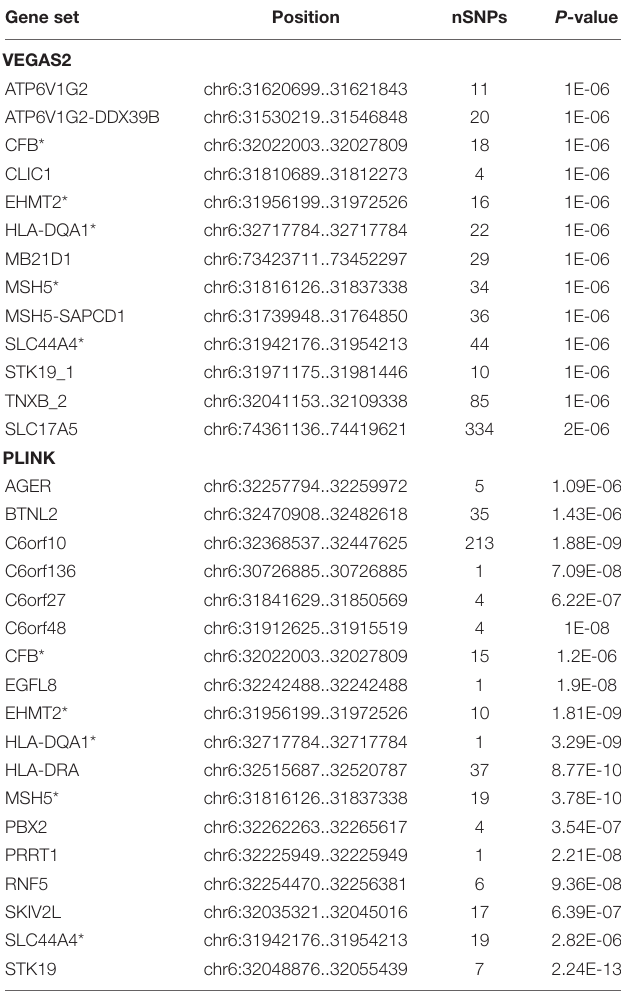
NSNP: number of single nucleotide polymorphisms. * represents the intersection of VEGAS2 and